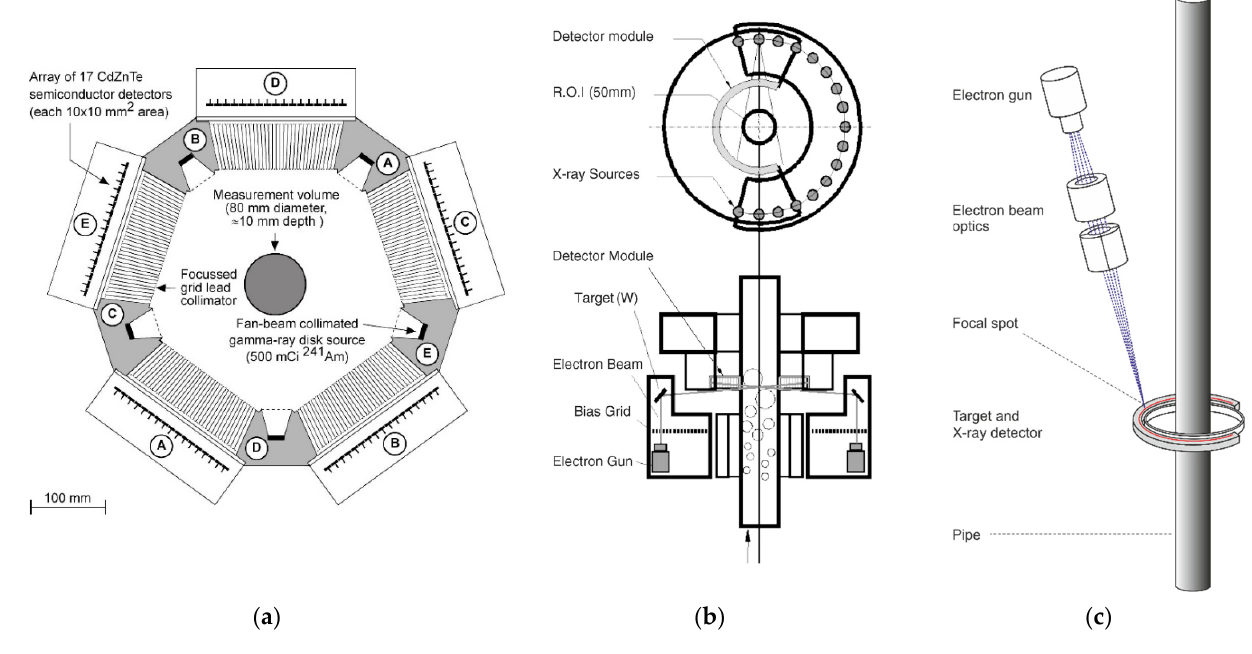
Figure 8. Fast radiation tomography systems: ( a ) University of Bergen fast gamma ray tomography scanner [103] (reproduced with permission from G.A. Johansen et al., Appl. Radiat. Isot. 2010, 68, 518–524; published by Elsevier, 2010). ( b ) Fast X-ray tomograph with 18 switched X-ray tubes of the National Institute of Advanced Industrial Science and Technology Japan [105] (reproduced with permission from H.-M. Prasser et al., Flow Meas. Instrument 16, 73–83; published by Elsevier, 2005). ( c ) Ultrafast electron beam X-ray scanner ROFEX of the Helmholtz-Zentrum Dresden-Rossendorf [108] (reproduced with permission from F. Fischer et al., Nucl. Eng. Des. 2010, 240, 2254–2259; published by Elsevier,